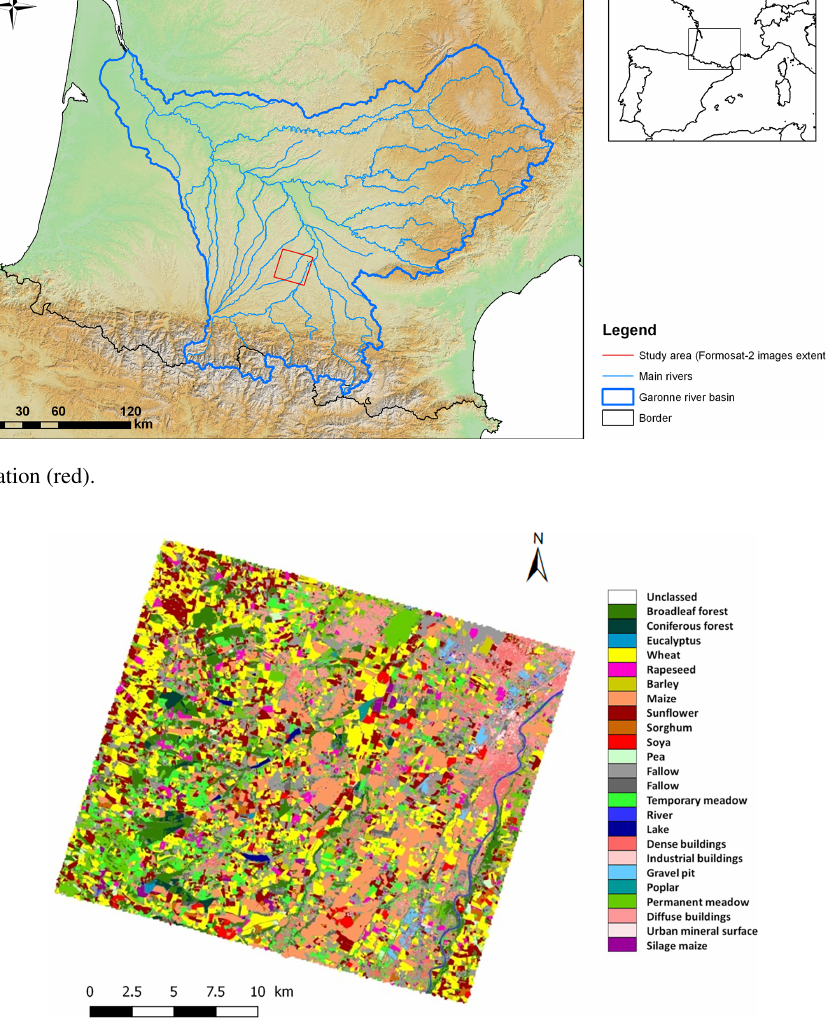
Figure 2. Land cover map for